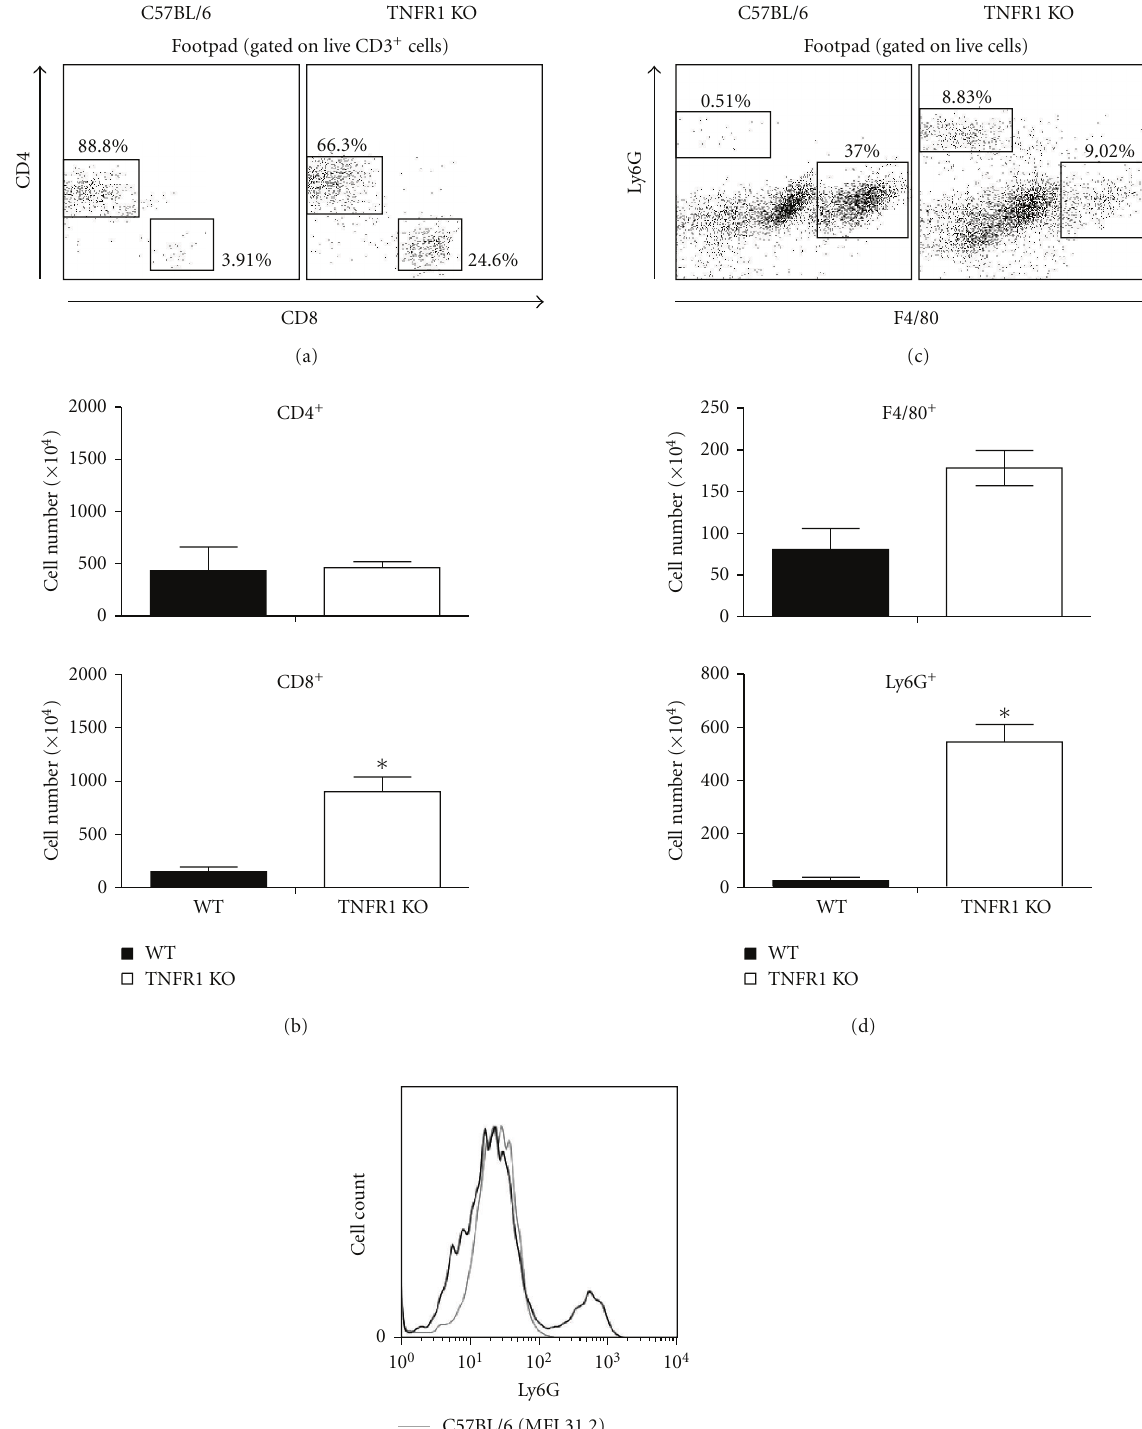
Figure 2: Cell populations in lesions from WT and TNFR1 KO mice infected with L. major . Mice were infected in the footpad with 1 × 10 6 L. major and 15 weeks post-infection the inflammatory cells were isolated from lesions and characterized by flow cytometry. (a) Dot plots and (b) absolute cell numbers of CD4+ and CD8+ T cells from pooled lesions from 4 mice per group. (c) Dot plots and (d) absolute cell numbers of F4/80+ and Ly6G+ cells from pooled lesions from 4 mice per group. (e) Ly6G fluorescence intensity. ∗ P < 0 . 05. Data are from one